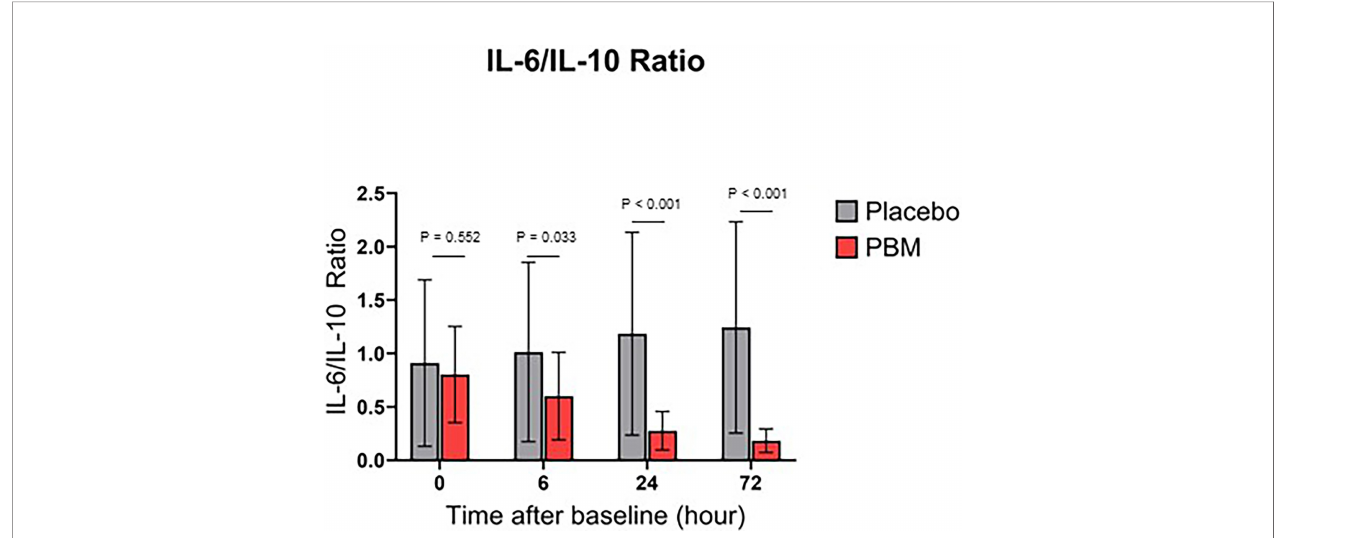
FIGURE 4 | IL-6/IL-10 Ratio over time, for Placebo and PBM